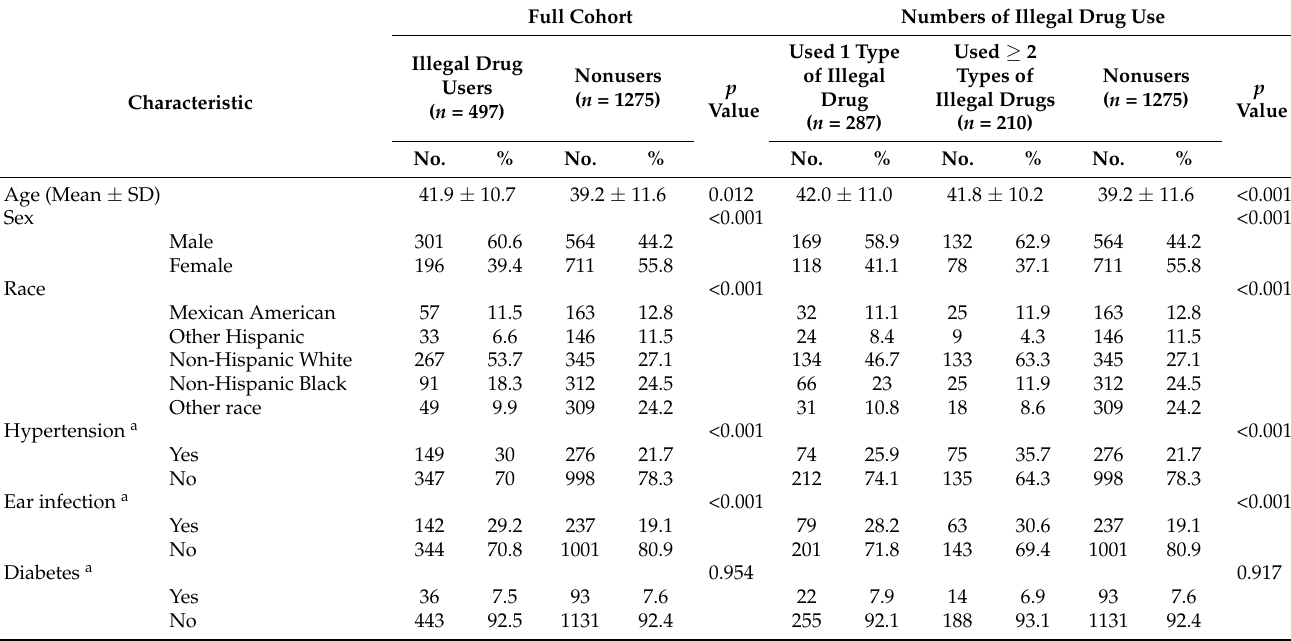
Table 1. Demographic characteristics and comorbidities of selected